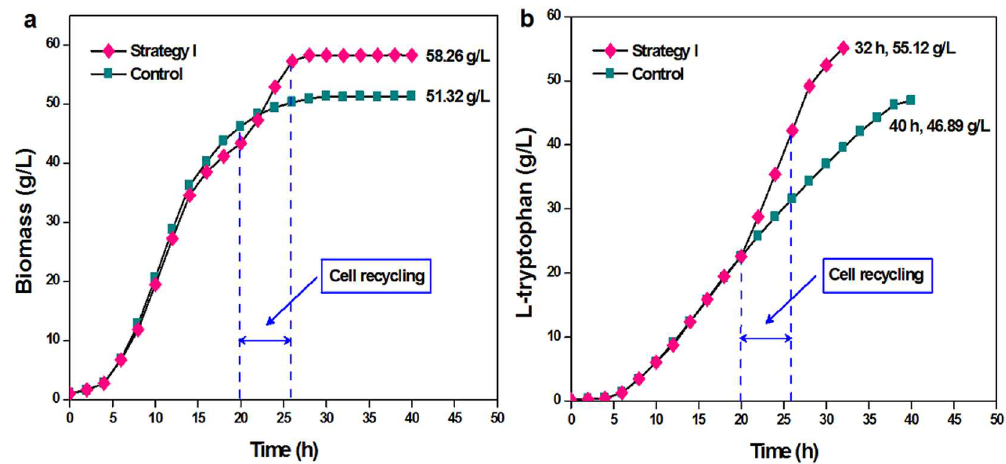
Fig 7. Comparisons of biomass (a), L-tryptophan production and fermentation period (b) in L-tryptophan fermentation by TRTHBPA between strategy I and the control (without cell recycling).